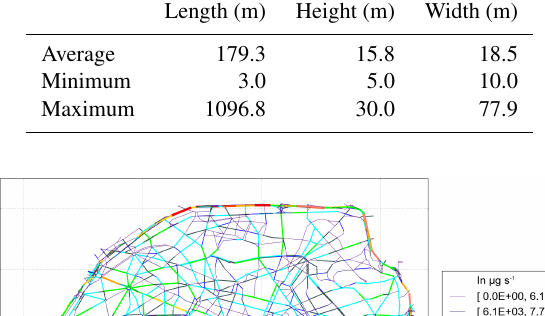
Table 2. Maximum, average and minimum street dimensions of the whole street network used in this study.